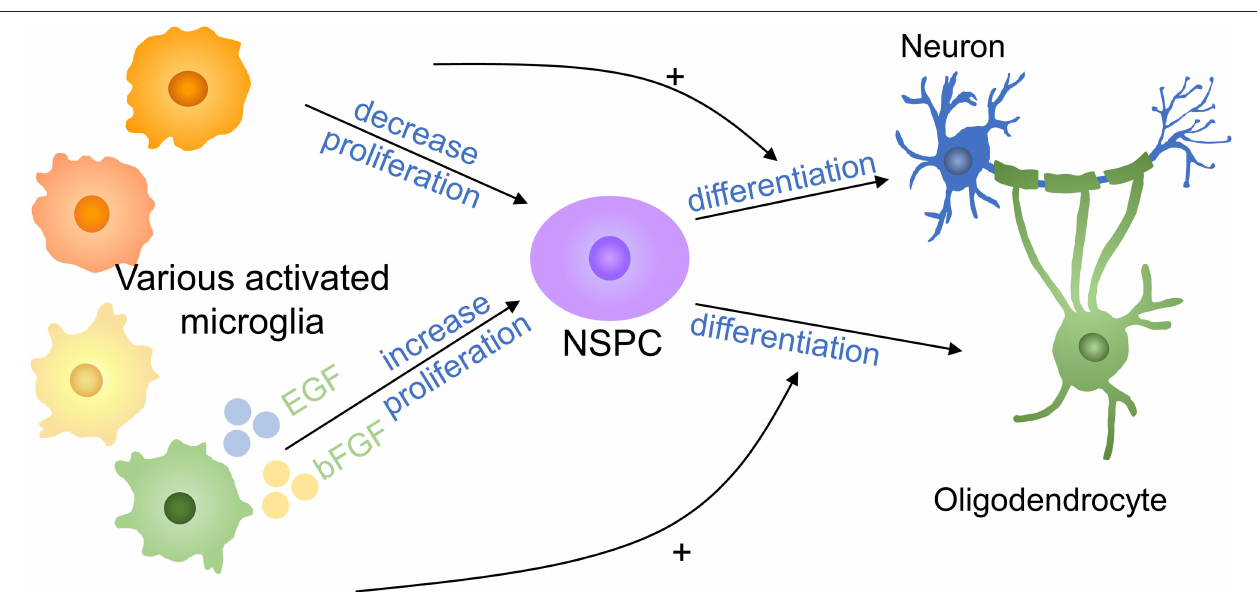
FIGURE 6 | Effects of microglia on NSPCs in SCI. Proinflammatory factors decrease the proliferation of NSPCs, whereas anti-inflammatory cytokines increase NSPC proliferation. Proinflammatory factors promote NSPC differentiation into neurons, whereas anti-inflammatory molecules promote NSPC differentiation into oligodendrocytes. + means promotion. NSPC, neural stem/progenitor